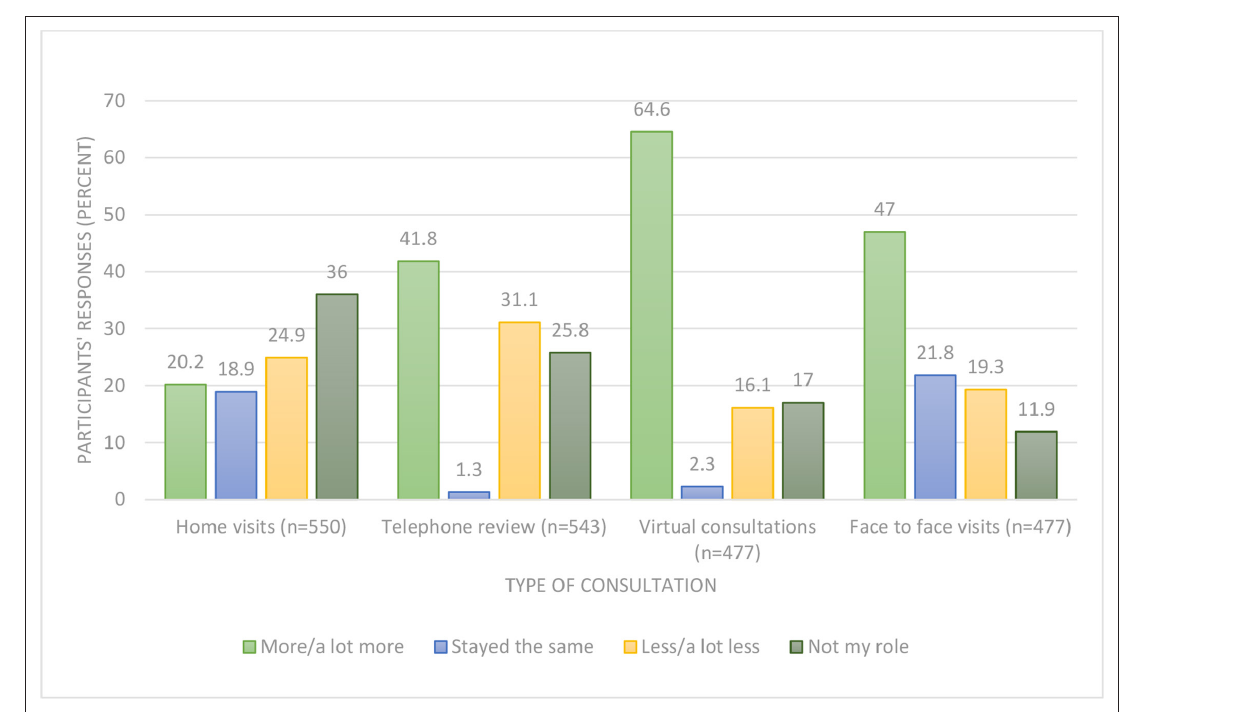
Figure 2 Changes in type of consultation